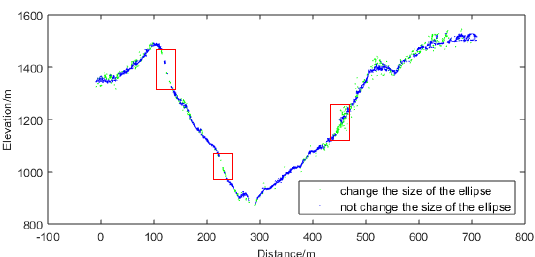
Fig 3. Results of signal points extraction (the green dots are the result of the ellipse size according to the slope, and the blue don’t change) The results of signal points extraction are shown in Figure 3. Parameters used in this paper are: , , Gaussian weight variance . Here 𝑎𝑎 = the blue dots represent the result without changing 10 𝑏𝑏 = 2 σ = 2 the size of the cluster ellipse, and the green dots represents the filter result of the ellipse size according to the gradient. The results within the